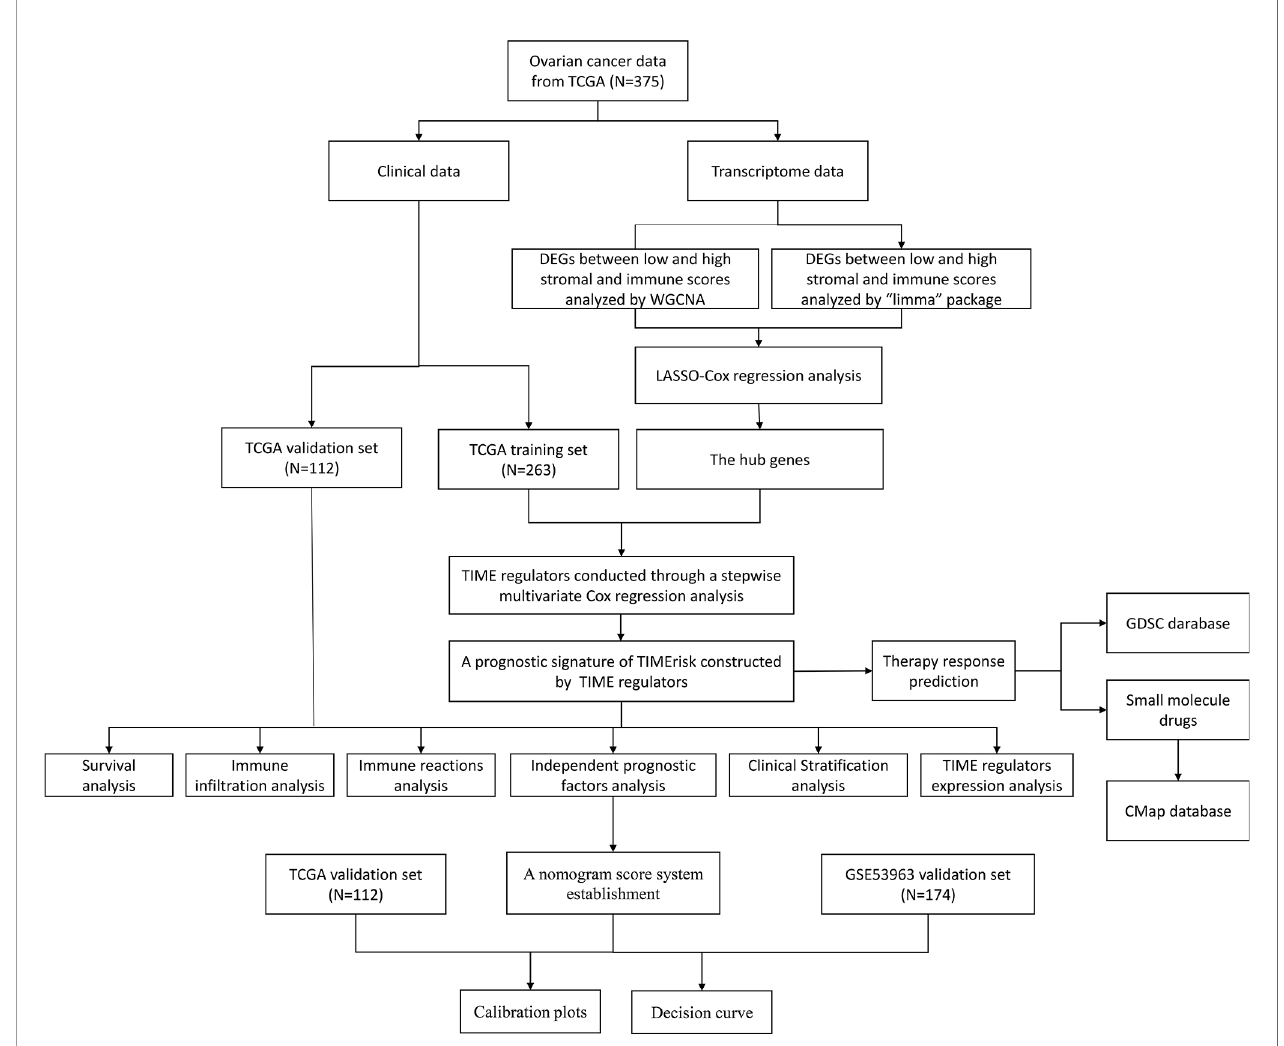
FIGURE 1 | The work fl ow of the